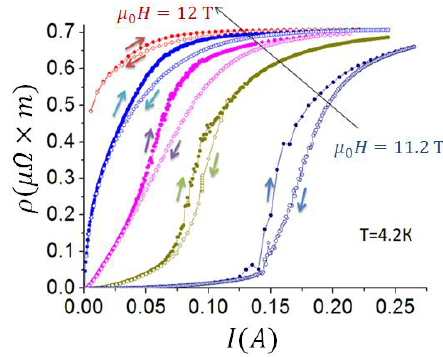
Fig. 2. A series of RCCs for a cold-rolled Nb-Ti tape, replotted from the VCCs (Fig. 1). The value of the magnetic field varies in the range from 11.2 T to 12 T in steps of 0.2 T. For fields of 11.2 T and 11.4 T, it is clearly seen that there is excessive voltage noise in the hysteresis region.